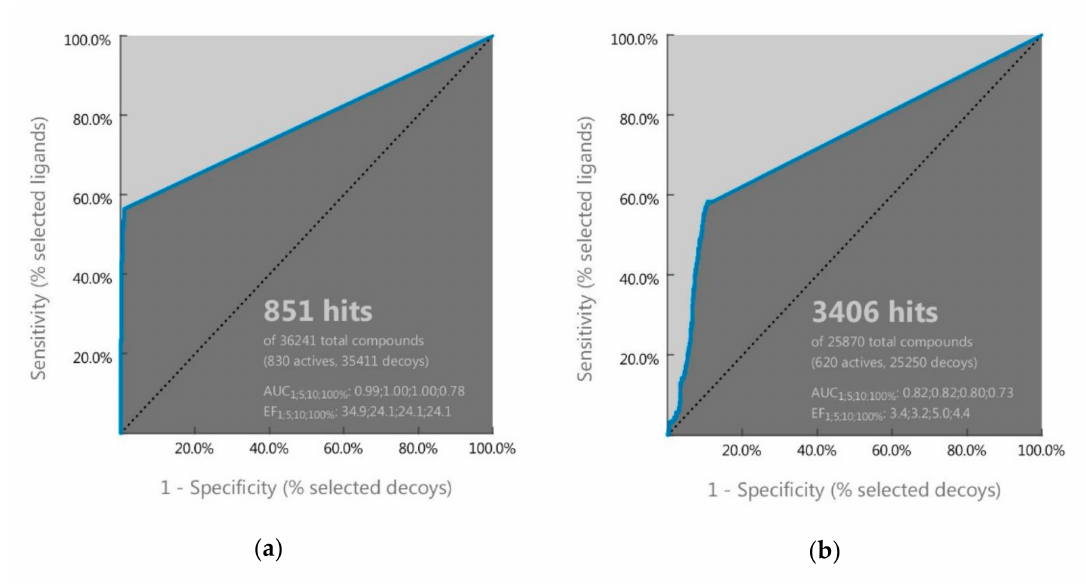
Figure 1. Receiver operating characteristic (ROC) curve validation of the selected pharmacophore